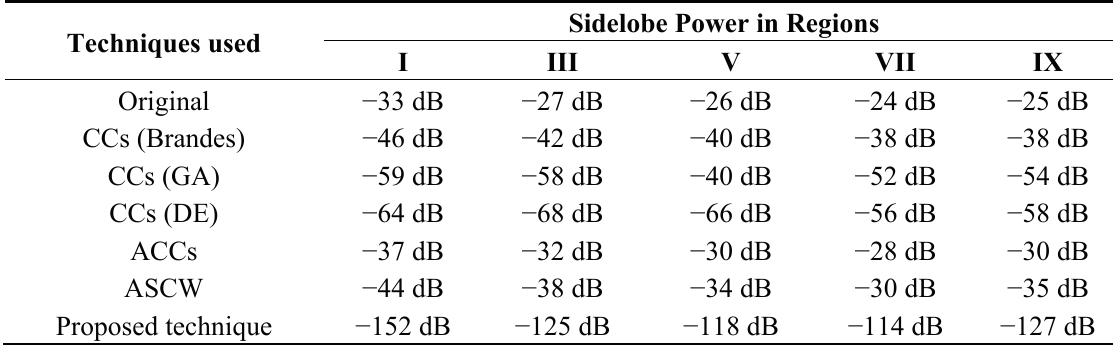
Table 4. Comparison of sidelobe suppression between existing and proposed techniques.